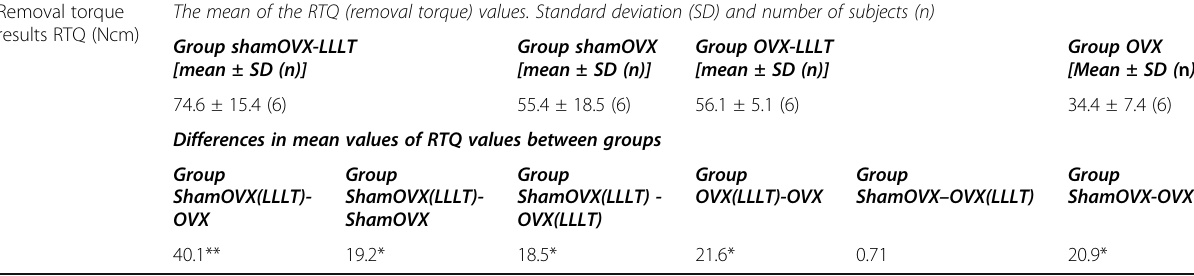
Table 1 The mean of the RTQ (removal torque) values and the difference between the groups Removal torque The mean of the RTQ (removal torque) values. Standard deviation (SD) and number of subjects results RTQ (Ncm)